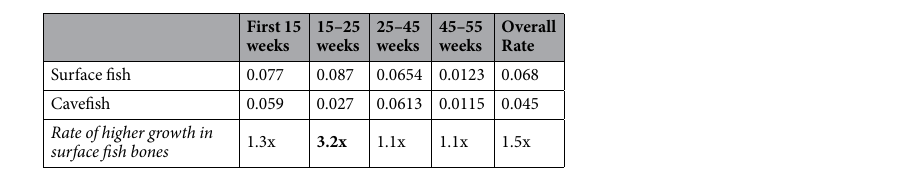
such as osteoporosis 19,20 . During bone resorption, osteoclasts attach to bony matrix and secrete tartrate-resistant acid phosphatase (TRAP), which facilitates bone degradation and resorption 21 . Whole-mount staining for osteoclasts in dissected SO3 bones revealed substantially elevated TRAP activity in cavefish SO3 bones (Fig. 4H). TRAP-positive staining aggregated in “channels” where bone fragments were actively separating from the larger element, suggesting osteoclasts mediate bone remodeling of SO3 bones in cavefish (i.e., mechanism 2). The lower level of TRAP staining observed in surface fish SO3 bones likely reflects normative levels of bone remodeling (Fig. 4G). At the ultrastructural level, transmission electron microscopy (TEM) imaging revealed that the larger SO3 element is completely separated from the bony fragment(s), with clusters of collagen fibrils and connective tissue between the elements (Fig. 4F). Interestingly, the inter-fragment area resembles the area between suborbital bones in surface fish (Fig. 4E). This suggests that the process of bone fragmentation leads to the formation of bony frag- ments that are structurally identical to distinct, mature bones.